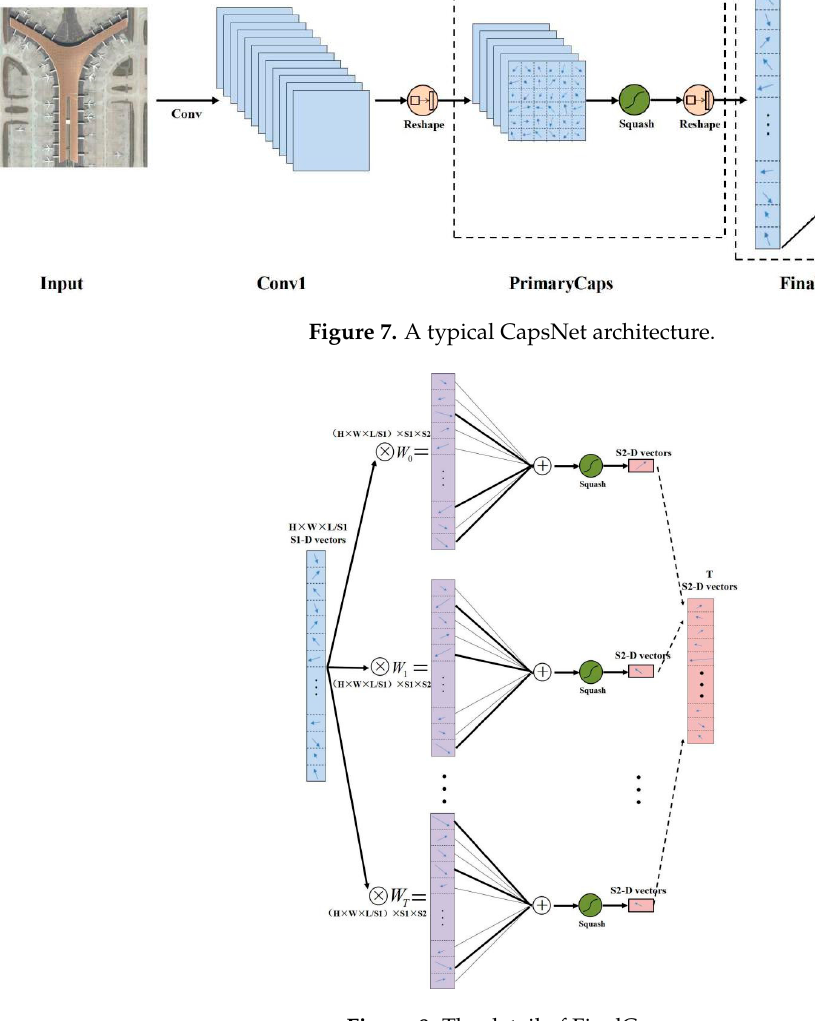
Figure 9. The architecture of the proposed classification method. As for CNN, two representative CNN models (VGG ‐ 16 and Inception ‐ V3) fully trained on the ImageNet dataset are used as initial feature map extractors, considering their popularity in the remote sensing field [25,27,28,35,53,56,59]. The “block4_pool” layer of VGG ‐ 16 and the “mixd7” of